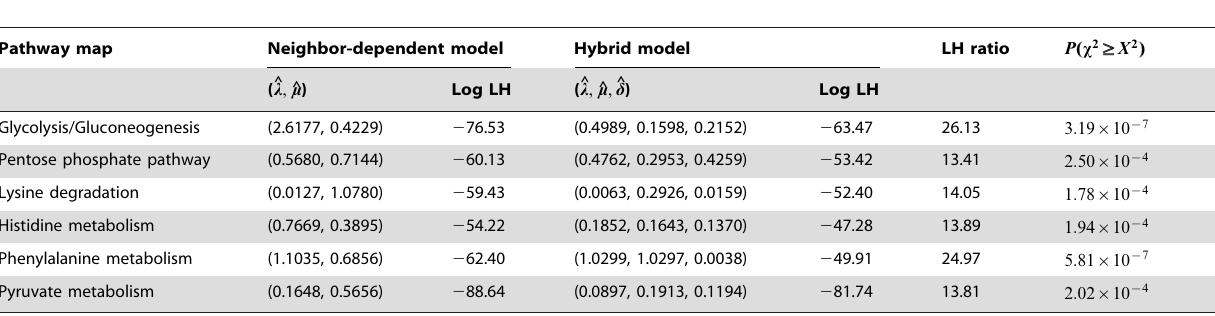
Table 1. Likelihood ratio test between the neighbor-dependent and hybrid models of metabolic evolution.